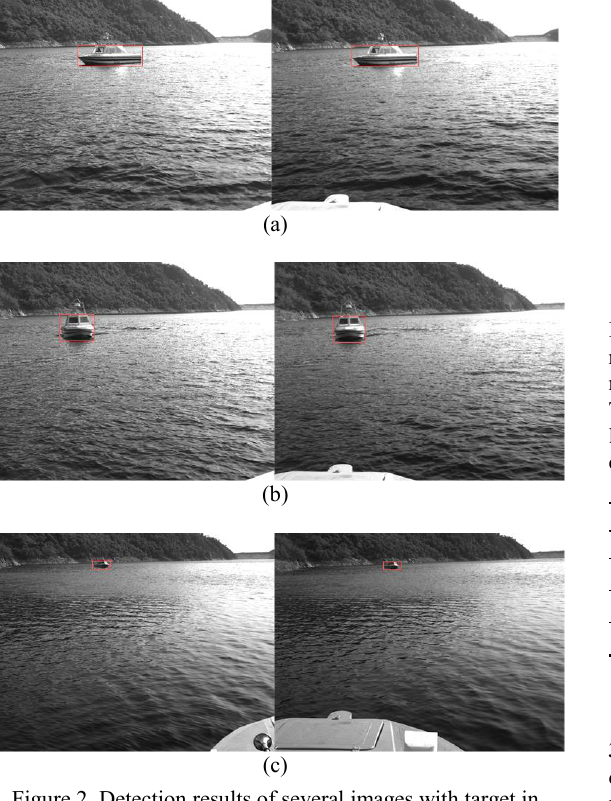
Figure 2. Detection results of several images with target in different directions and distances captured at the reservoir. The detection results are marked as red rectangles.